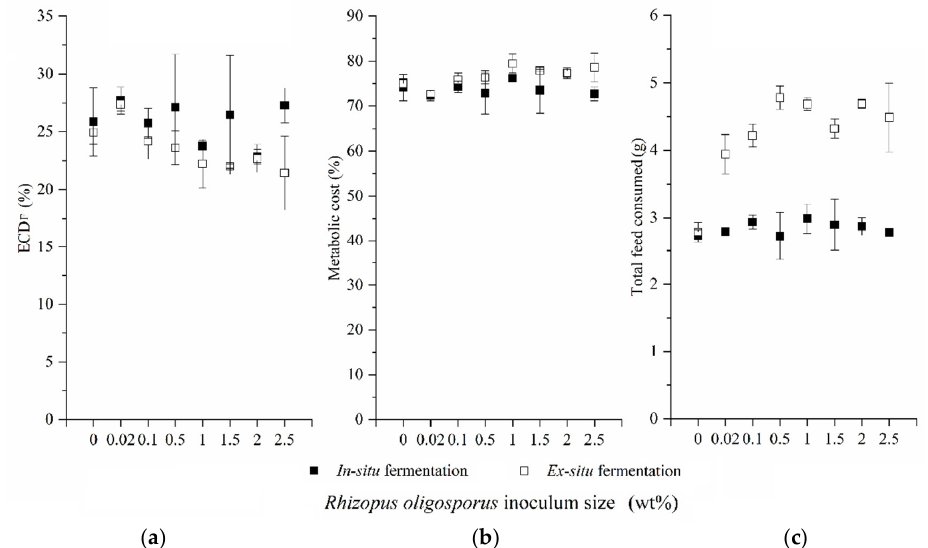
Figure 2. Conversion of in situ- and ex situ-fermented CEW into BSFL biomasses measured in terms of ECD F ( a ), metabolic cost ( b ), and total feed consumed ( c ).